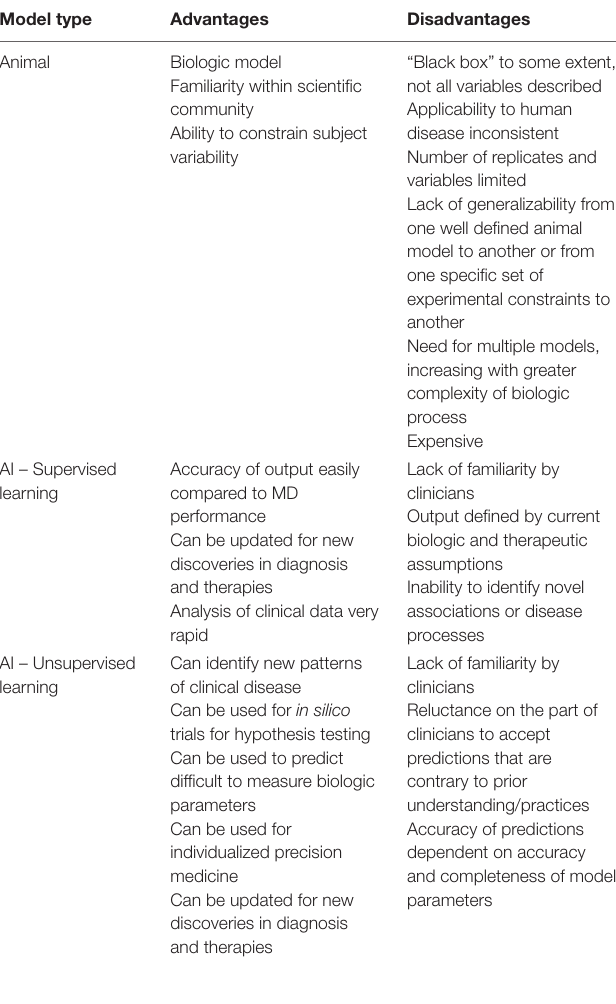
TABLE 1 | Comparison of animal models and machine models of human disease. Model